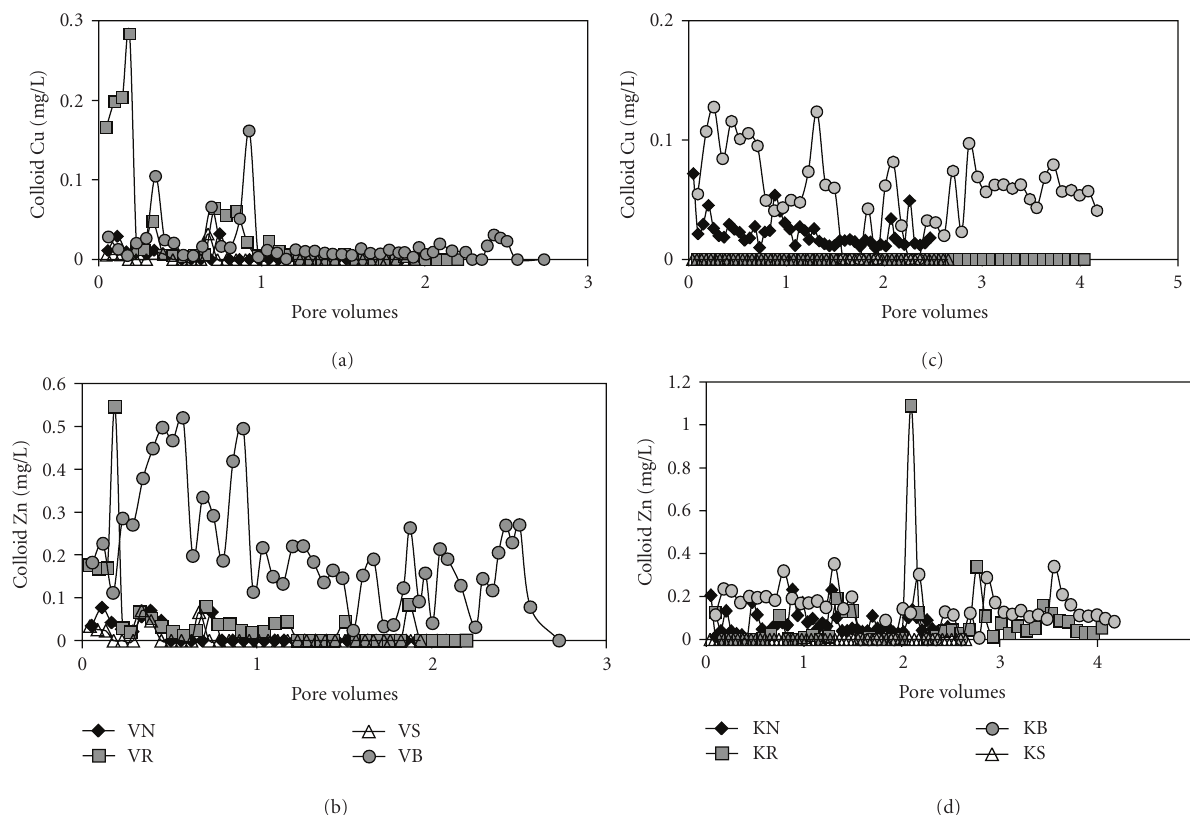
Figure 2: Colloid associated concentrations (mg L − 1 ) of Cu and Zn in Virginia (a, b) and Kentucky (c, d) monolithsover the entire leaching. VN: Virginia Natural, VR: Virginia Reclaimed, VS: Virginia Spoil, VB: Virginia Biosolids, KN: Kentucky Natural, KR: Kentucky Reclaimed, KS: Kentucky Spoil, KB: Kentucky